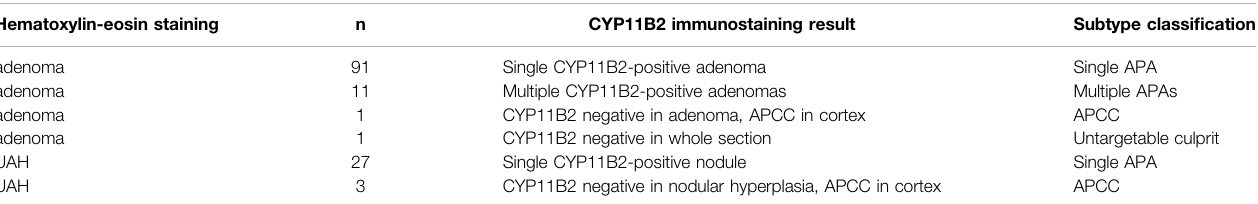
CYP11B2 negative in nodular hyperplasia, APCC in cortex UAH, unilateral adrenal hyperplasia; n, number of patients; APCC, aldosterone-producing cell cluster; APA, aldosterone-producing further compared the preoperative clinical and endocrinological the wild-type group. Serum potassium level ( p (cid:1) 0.032) was parameters of the patients between the wild-type staining and signi fi cantly lower in the abnormal staining group than that in abnormal staining groups ( Supplementary S1 ). the wild-type staining group. However, there were no signi fi cant differences in SBP ( p (cid:1) 0.505), DBP ( p (cid:1) 0.504), age ( p (cid:1) 0.146), sex ( p (cid:1) 0.471), family history of hypertension ( p (cid:1) 0.763), BMI ( p (cid:1) 0.800), and PRA ( p (cid:1) 0.208) between these two groups. As for signi fi cantly higher in the abnormal staining group than that in the immunoreactivity score, the CYP11B2 score ( p (cid:1) 0.000) was